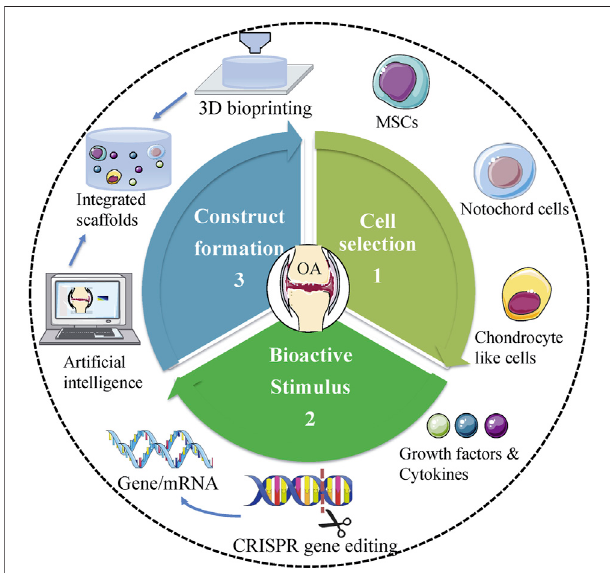
FIGURE2| FuturetrendsoftissueengineeringintreatingOA.Propercell selection, appropriate bioactive stimulus, and perfect design of scaffolds are central to tissue engineering. Novel scienti fi c technologies, including CRISPR gene editing, 3D bioprinting, and AI should be used to facilitate the development of tissue engineering in treating